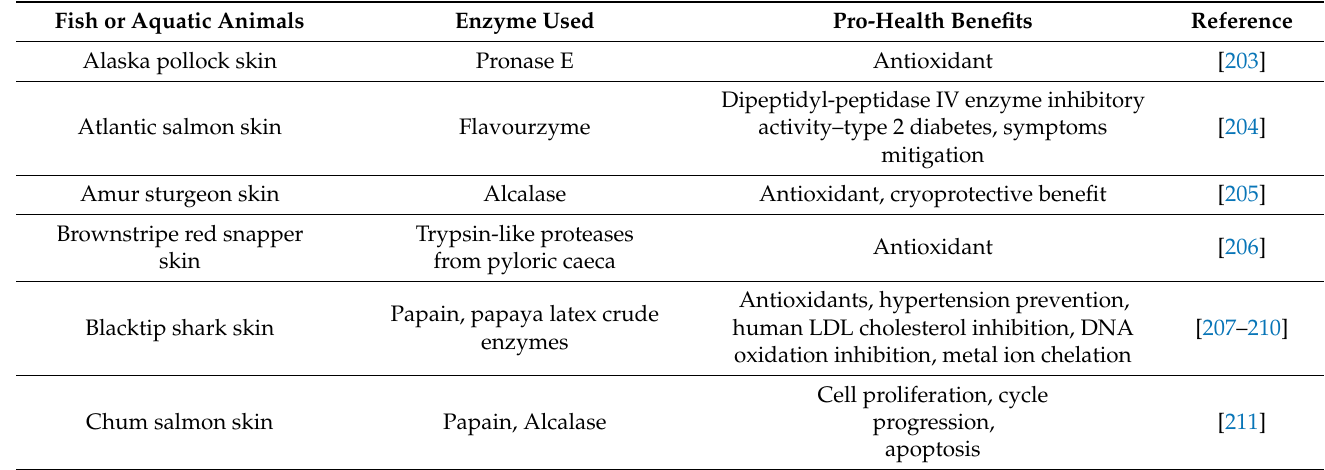
Table 7. Health benefits of aquatic animal gelatin hydrolysates and gelatin-derived peptides with used